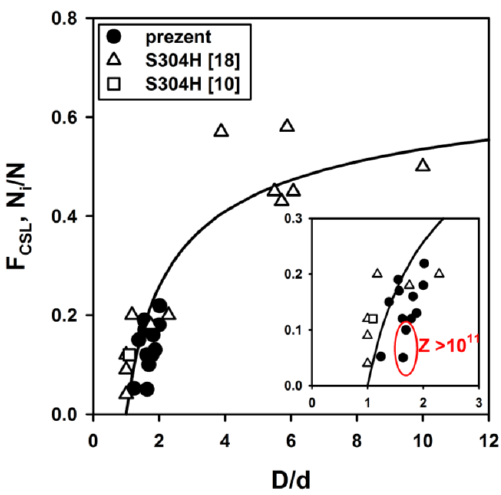
Figure 9. Relationship between the fraction of CSL boundaries ( F CSL ) and the grain/subgrain size ratio ( D / d ).